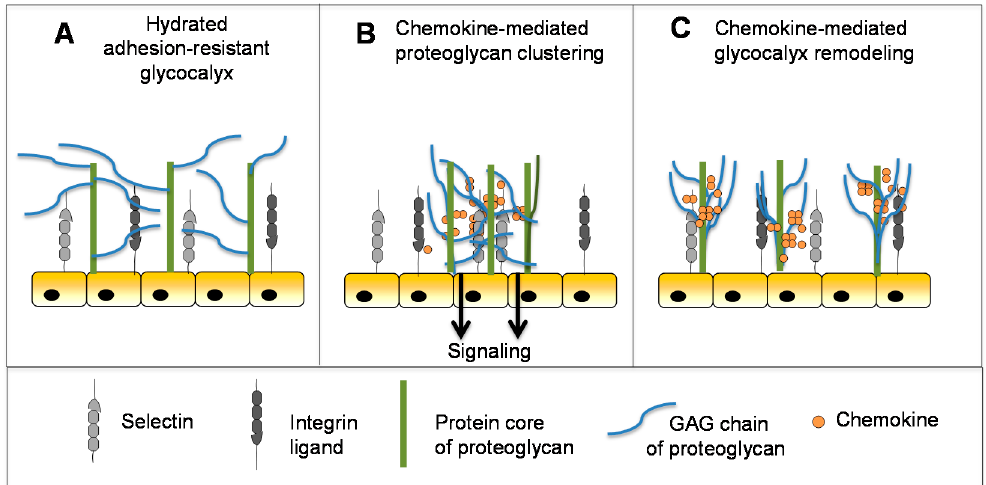
Figure 5. Functional effects of chemokine–GAG interactions. ( A ) The GAG chains of proteoglycans form a hydrated adhesion-resistant surface on endothelial cells that inhibits leukocyte transmigration. ( B , C ) Binding of chemokines to the HS chains of proteoglycans may promote: clustering of the syndecans and chemokine–receptor independent signaling ( B ); or remodeling of the endothelial glycocalyx to enable leukocyte transmigration ( C ). Figure adapted from [31].